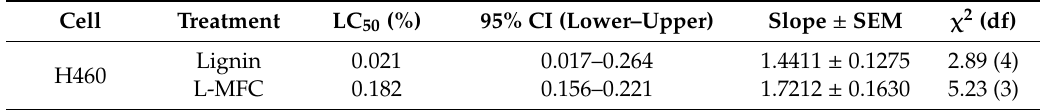
Table 4. LC 50 value of L-MFC in H460 cells.